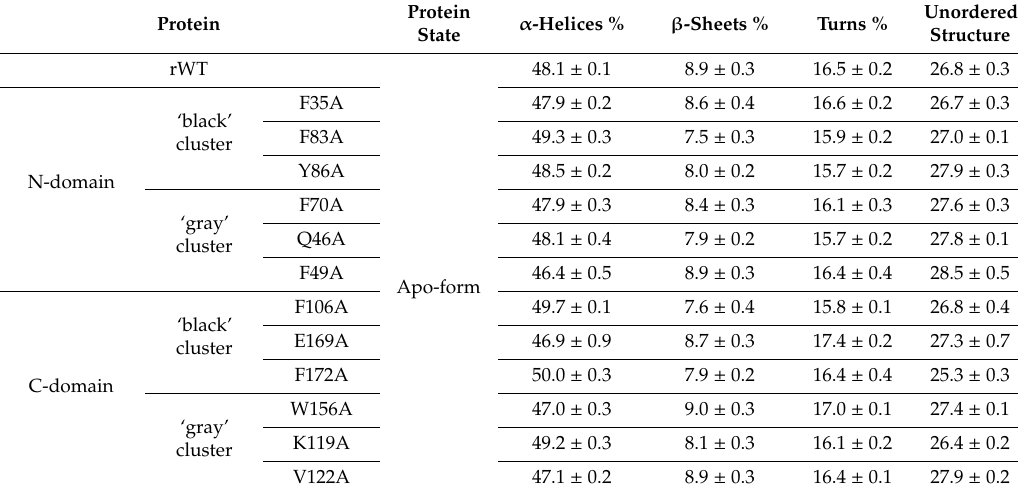
Figure 2. Effects of alanine substitutions in the ‘black’ ( A ) and ‘gray’ ( B ) clusters on α -helices content of recombinant wild type human recoverin in the absence of bound metal ions and in the presence of 1 mM CaCl 2 . Vertical bars show accuracy of α -helices content determination. Table 1. Secondary structure fractions estimated from the far-UV CD spectra of apo- (1 mM EDTA), Mg 2 + - (1mM MgCl 2 , 1 mM EGTA) and Ca 2 + -loaded (1 mM CaCl 2 ) forms of recombinant wild type human recoverin and its cluster mutants.